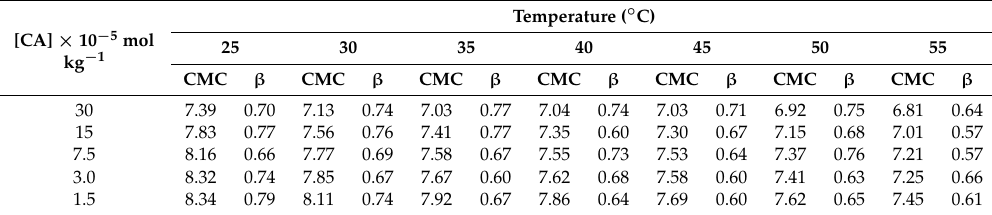
Table 1. CMC (mM kg −1 ) and mean degree of micellization (β) in the SDS–CA micellar system at variable mole ratios as calculated from electrical conductivity plots. The uncertainly values are below 10%.